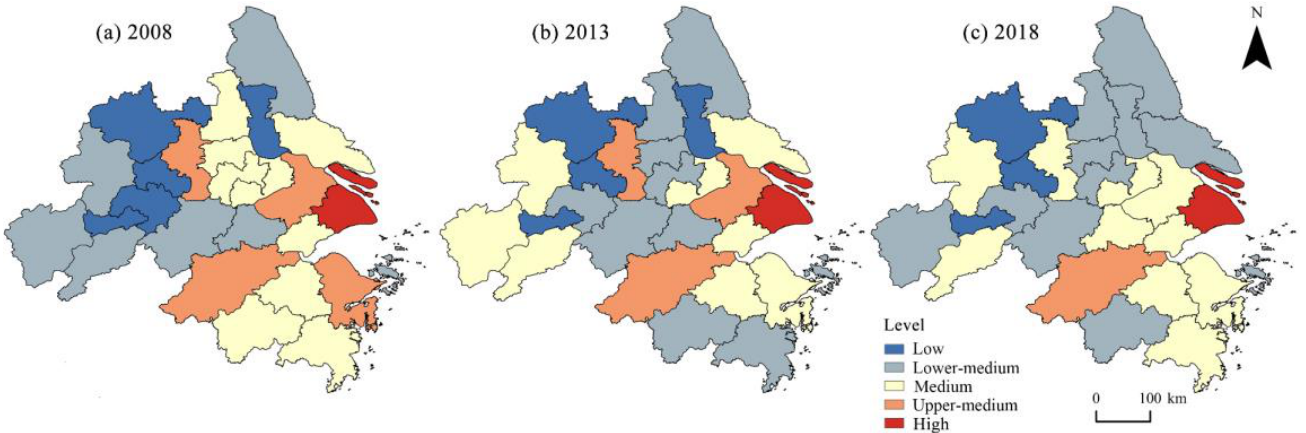
Figure 3. Spatial temporal pattern of Yangtze River Delta tourism industry in 2008 ( a ), 2013 ( b ), and 2018 ( c